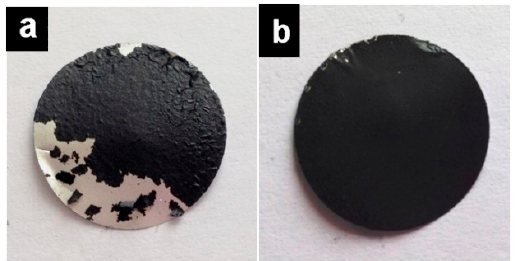
Figure 4. Photographs of LMO electrodes after 200 charge–discharge cycles: ( a ) LMO PVDF ; and ( b ) LMO PEDOT:PSS/CMC (our data from Ref. [66]).